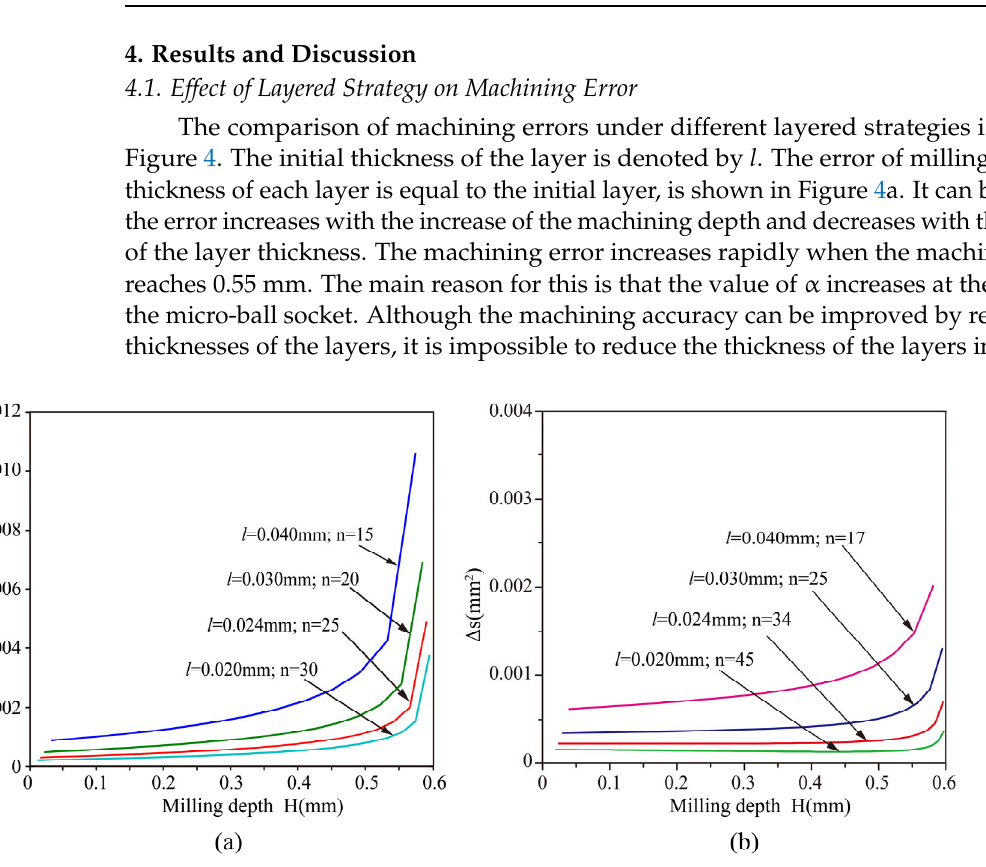
Figure 4. The error of milling with different layered strategies ( a ) constant thickness, ( b ) proportional variable thickness.